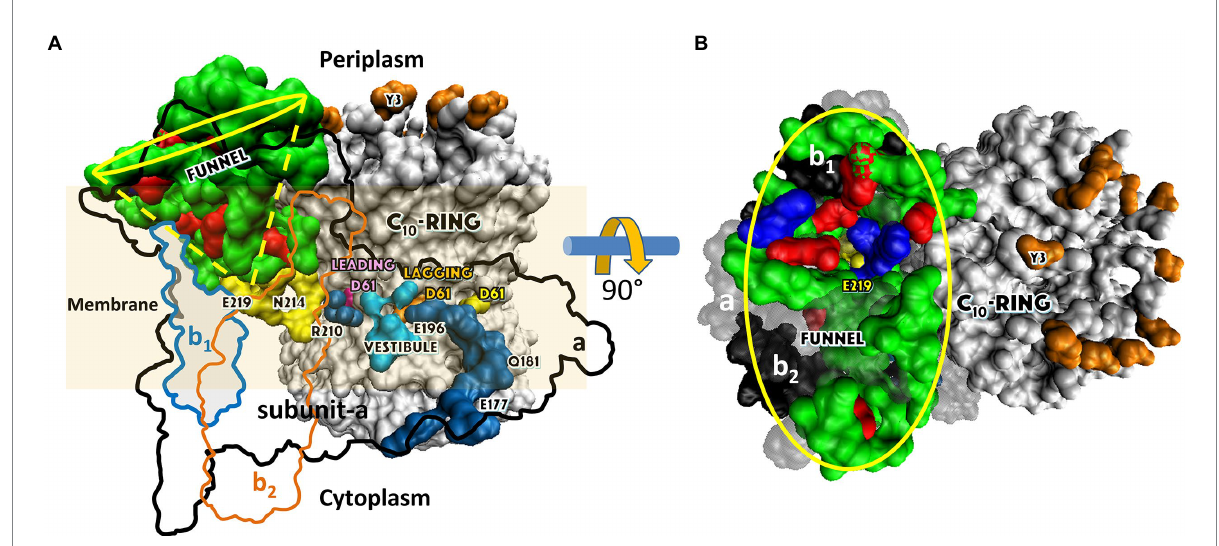
FIGURE 13 Aqueous Funnel of charged and polar groups can serve as an antenna to supply protons to the input channel. (A) Transmembrane view of E. coli F O (pdb-ID 6OQR) showing the path of charged and polar residues across the membrane. Outlines indicate space occupied by hydrophobic residues in subunit-a (black line), subunit-b 1 (blue line), and subunit-b 2 (orange line). The inner surface of the Funnel, which is lined with polar residues and loop regions (green), acidic groups (red) and histidines (blue) from subunit-a and the subunit-b 1 N-terminus, is exposed to the periplasm at its wide end that narrows to aE219 (yellow) at the bottom. The input channel (yellow) extends from aE219 to aN214 and aQ252, which are proximal to aR210. Between aR210 and the Output Channel (dark blue) the leading (pink) and lagging (orange) cD61 groups rotate through a Vestibule lined above and below the cD61 rotation plane by polar sidechains (light blue) that decrease the dielectric constant of the vestibule from that of the lipid bilayer. A protonated cD61 exposed to the lipid bilayer (yellow) is also visible. (B) Periplasmic surface of F O showing the interior surface of the Funnel (yellow oval) lined with charged and polar groups from subunit-a and subunit-b 1 as in (A) that narrows to aE219 (yellow) at the bottom where the input channel begins. Hydrophobic residues are shown of subunit-a (gray), subunits-b 1 and b 2 (black), and the c-ring (white). The cY3 sidechains (orange) are shown to indicate the orientation of the periplasmic surface of the c-ring. This figure was modified from Yanagisawa and Frasch,